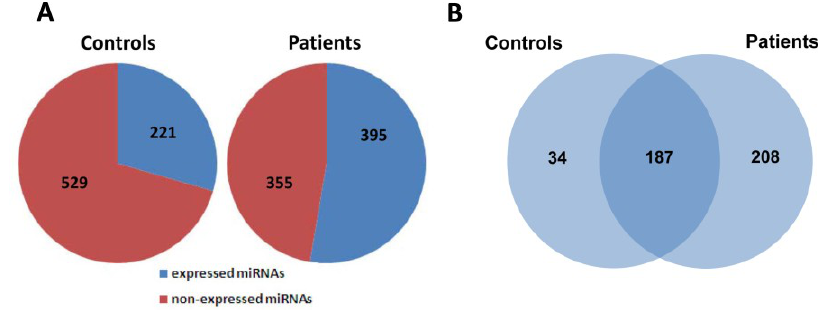
Figure 2. The serum levels of miR-17, miR-20a, miR-106a and miR-376c were determined by quantitative RT-PCR in individual healthy controls ( n = 36) and patients ( n = 21). Expression levels of four miRNAs were normalized to cel-miR-238 (Log ** p < 0.01, * p <